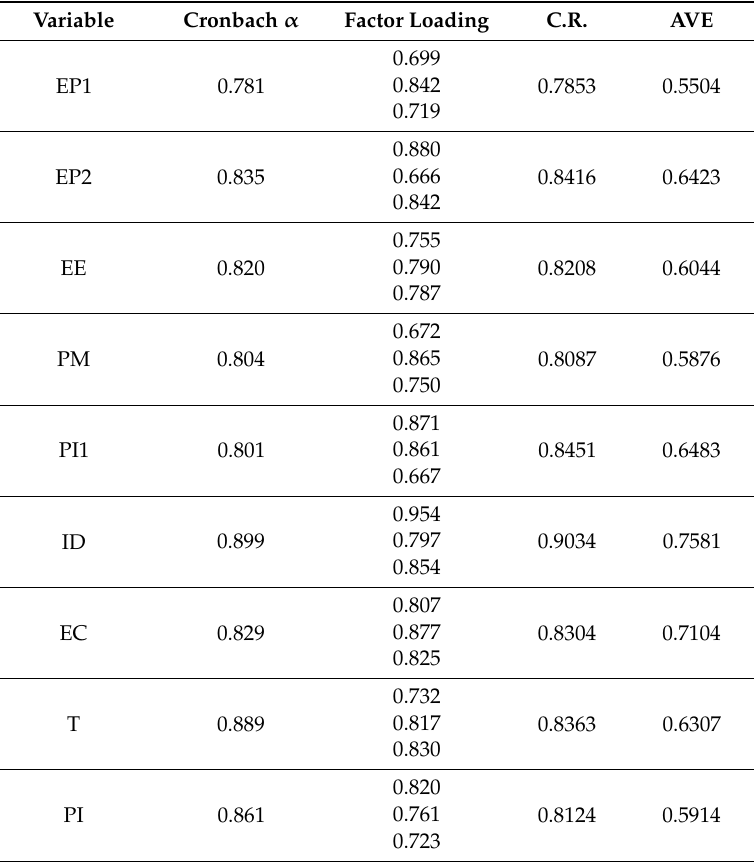
Table 3. Reliability and validity test.